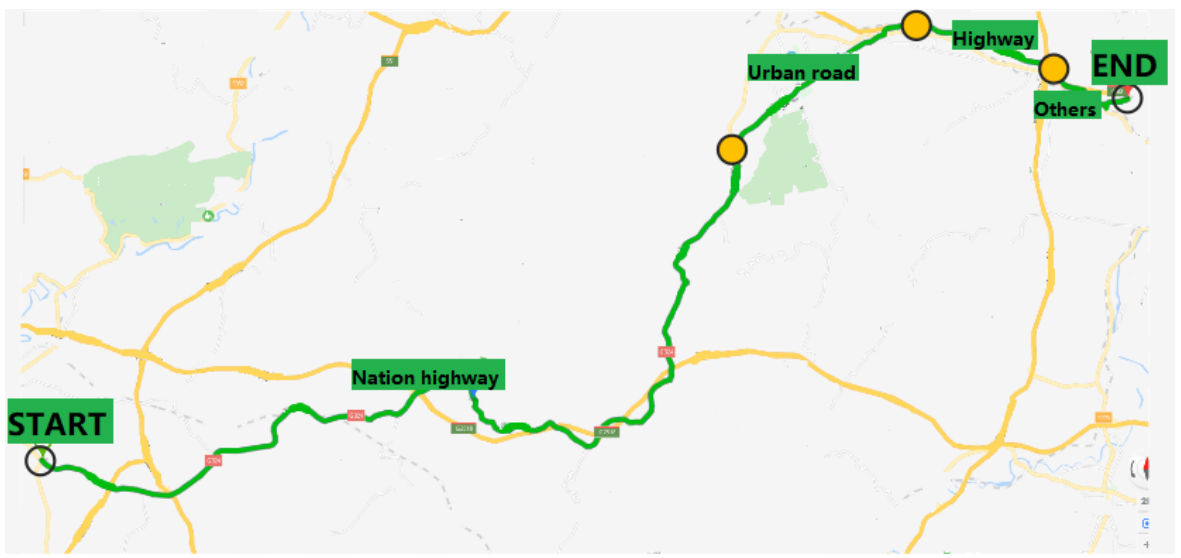
Figure 9. The segmentation of route in map.